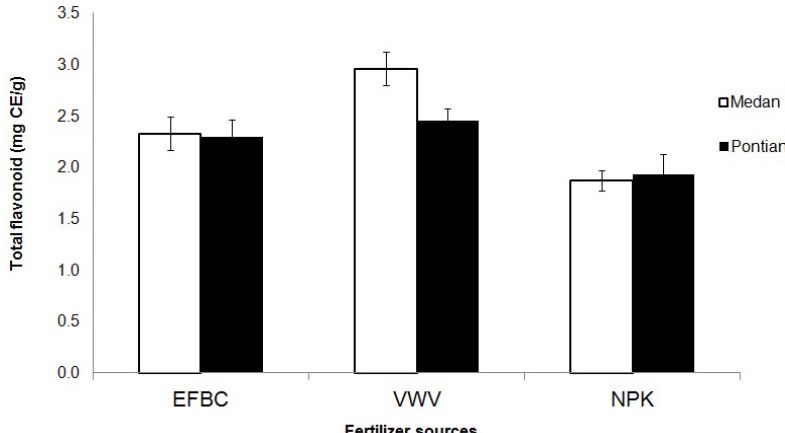
Figure 1. Flavonoids content in tubers of cassava treated with different fertilizer sources.